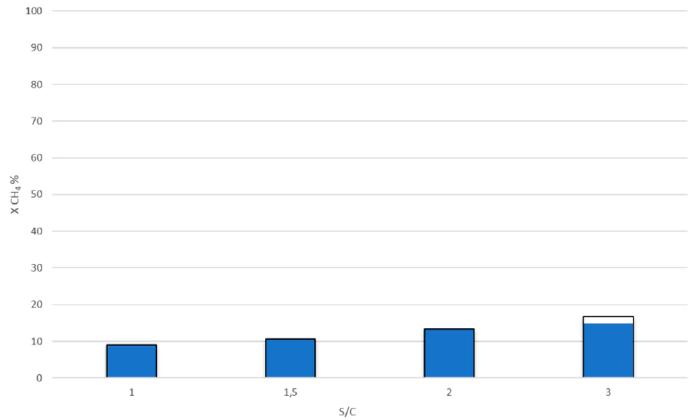
Figure 9. Comparison among tests carried out on Rh0.6-CL-R-CZOm at 30,000 h − 1 , 10 atm and 500 °C. The graph reports the methane conversion (blue) with respect to the equilibrium values (empty bars with black frame) versus different S/C ratios.